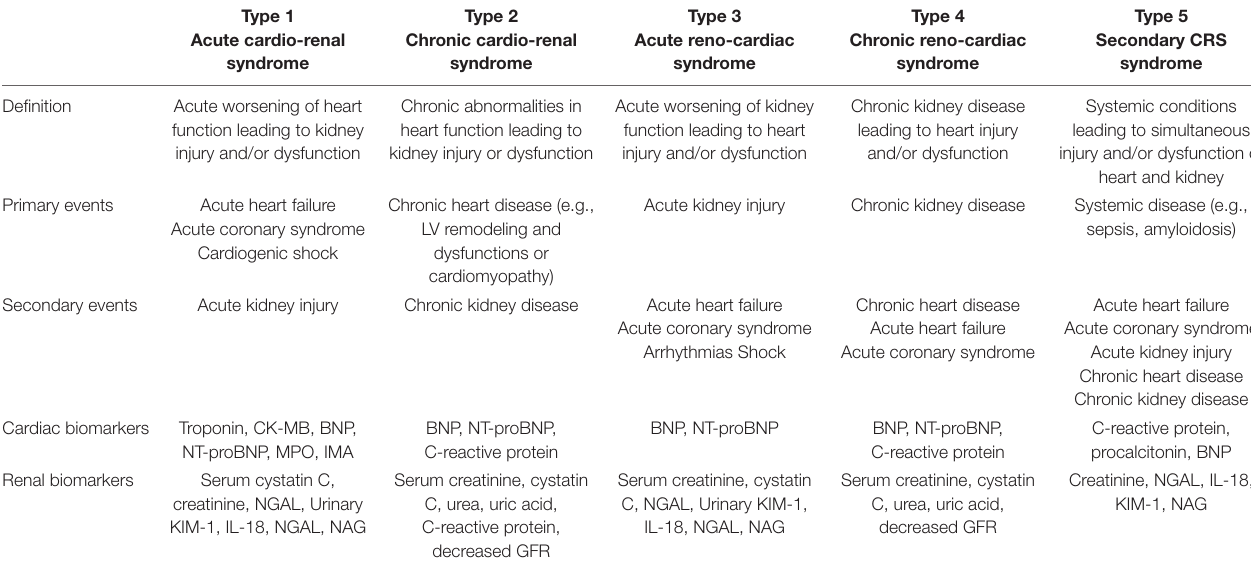
TABLE 1 | Classification of the clinical types of CRS.